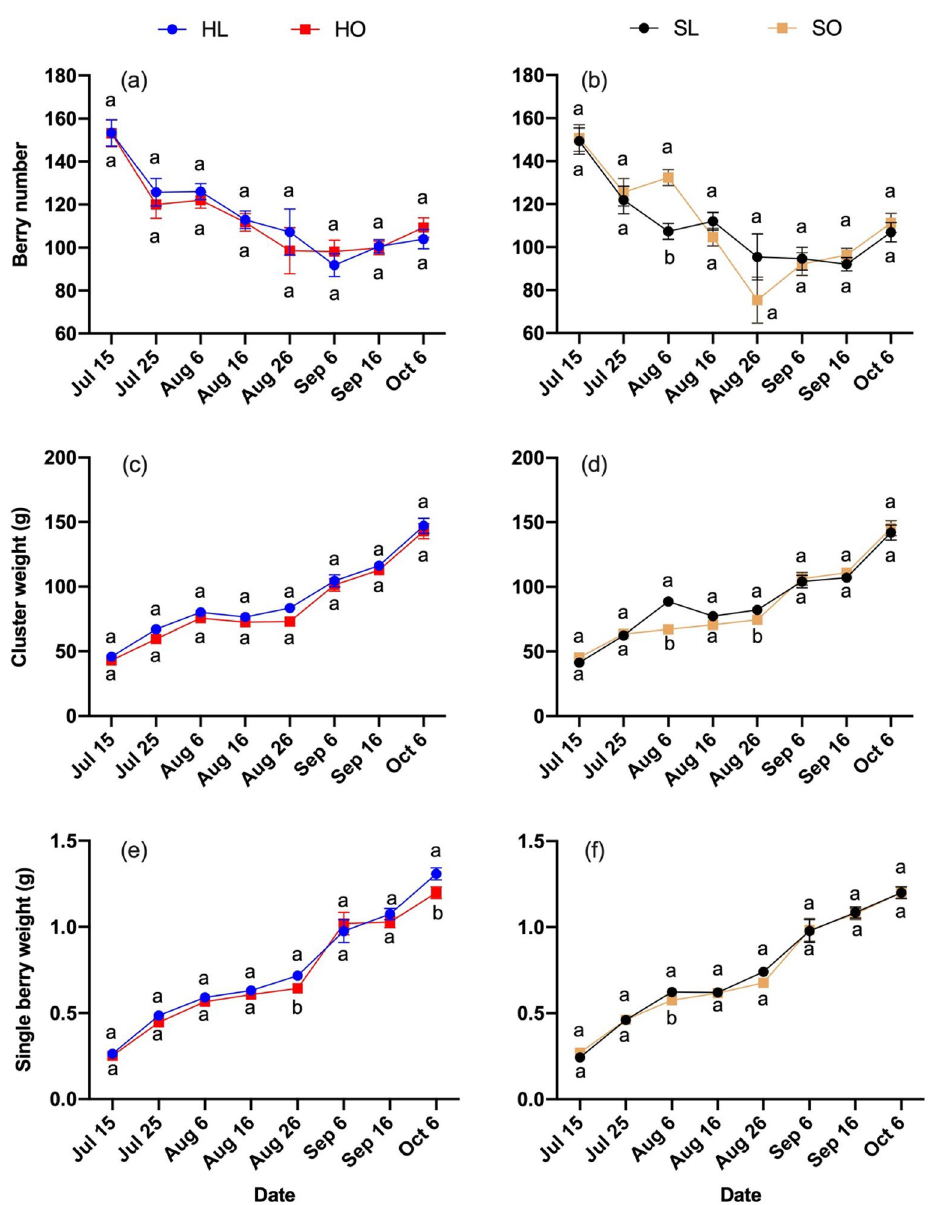
Figure 3. Berry weight traits in response to different treatments during the growing season in 2019 of ‘Riesling’. Berry weight traits: ( a , b ) Berry number, ( c , d ) Cluster weight, ( e , f ) Single berry weight. Treatments: (HL) Hedging with laterals, (HO) Hedging without laterals, (SL) Shoot wrap with laterals, (SO) Shoot wrap without laterals. Different lower-case letters showed significant differences at P ≤ 0.05